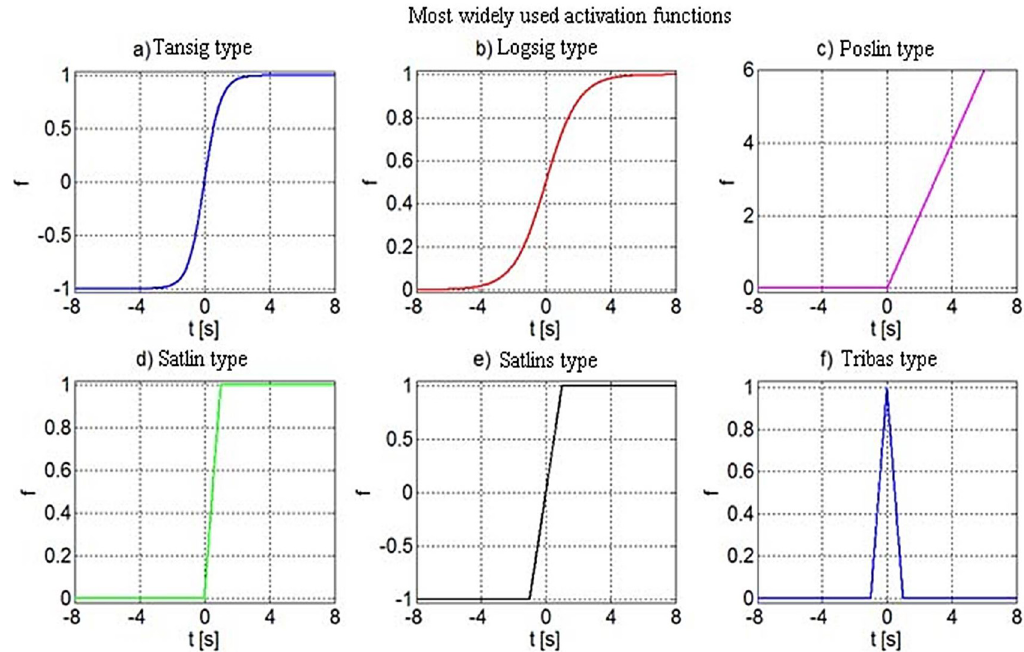
Figure 2. Activation